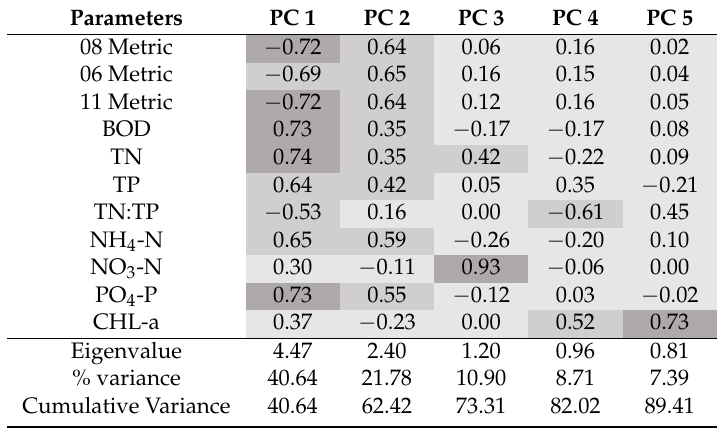
Table 9. Principal components and their loading values along with eigenvalue and percent variances in Guem River watershed.